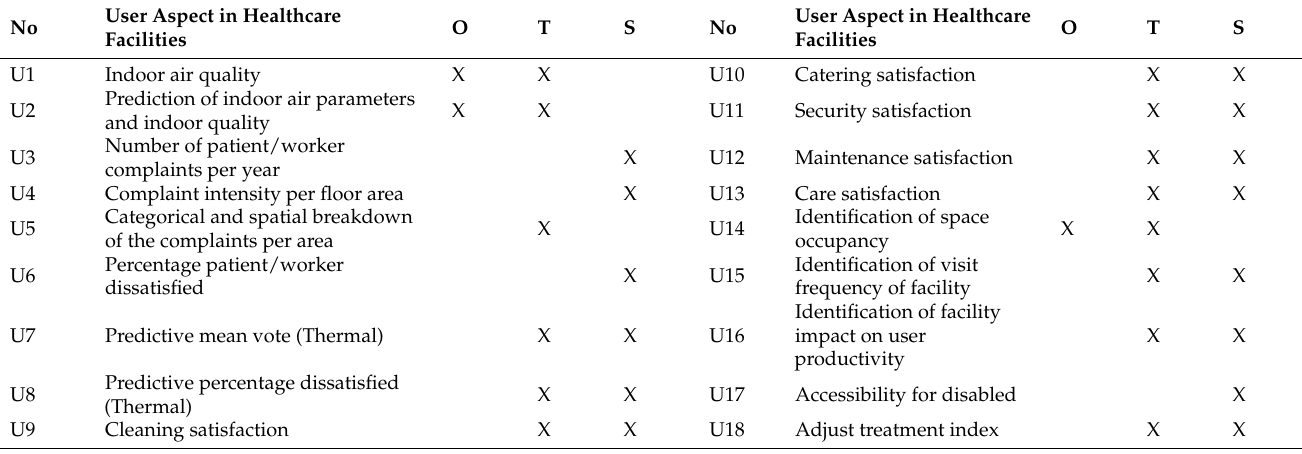
Table 2. FM KPIs for user aspect in healthcare facilities (O: operational, T: tactical, S: